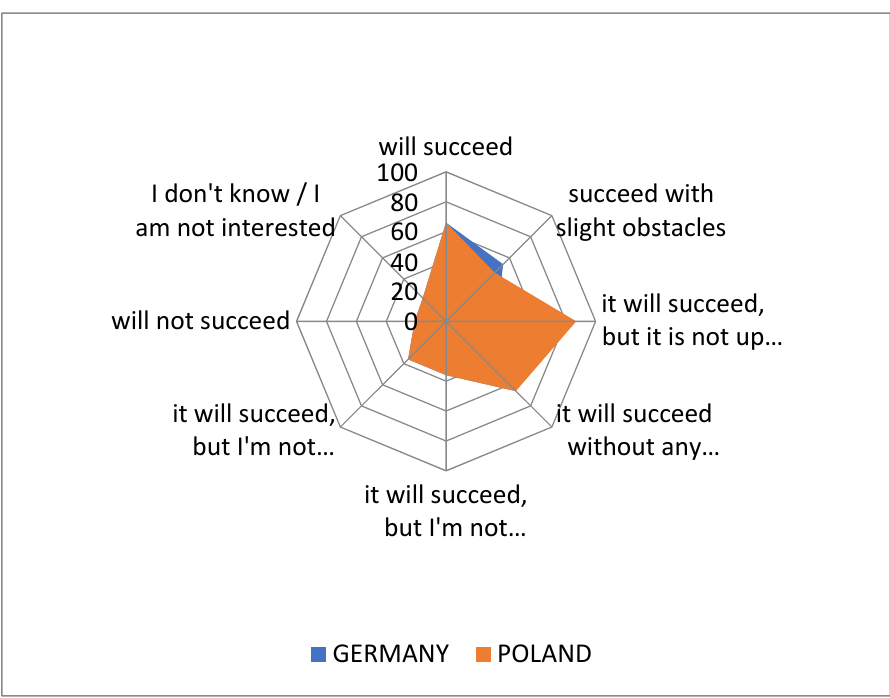
Figure 25. Opinion of people running an enterprise without a marriage union (cohabitation).